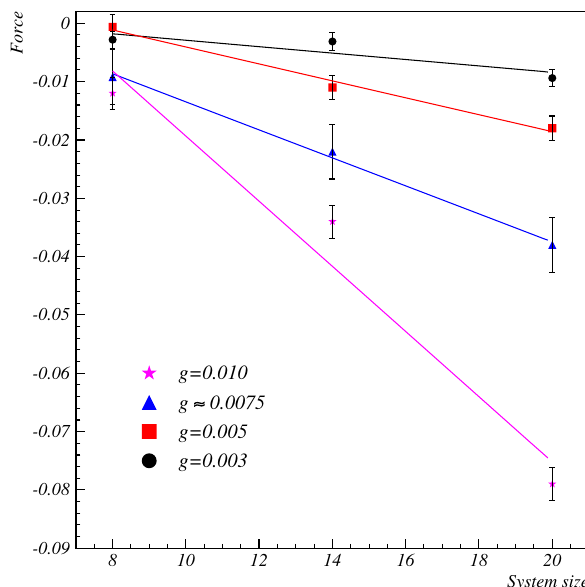
Fig. 12 Potentials in a two-dimensional space obtained when keep- ing only the ∂φ∂φ term in the Lagrangian. In this semi-log graph, the expected logarithmic potential is rectilinear. The vario u s s y mbols rep- resent different boundary conditions; see main text